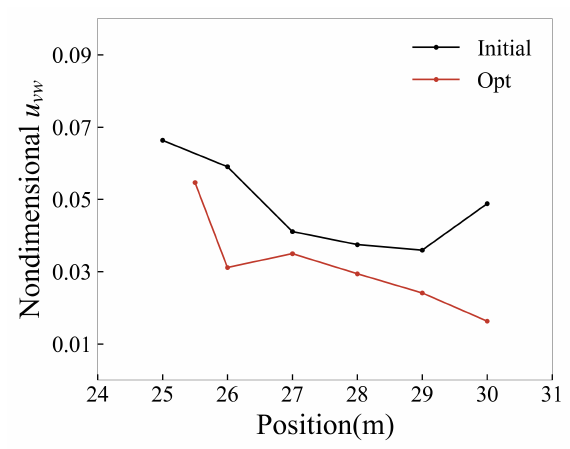
Figure 24. Distance of the downstream vortex core.